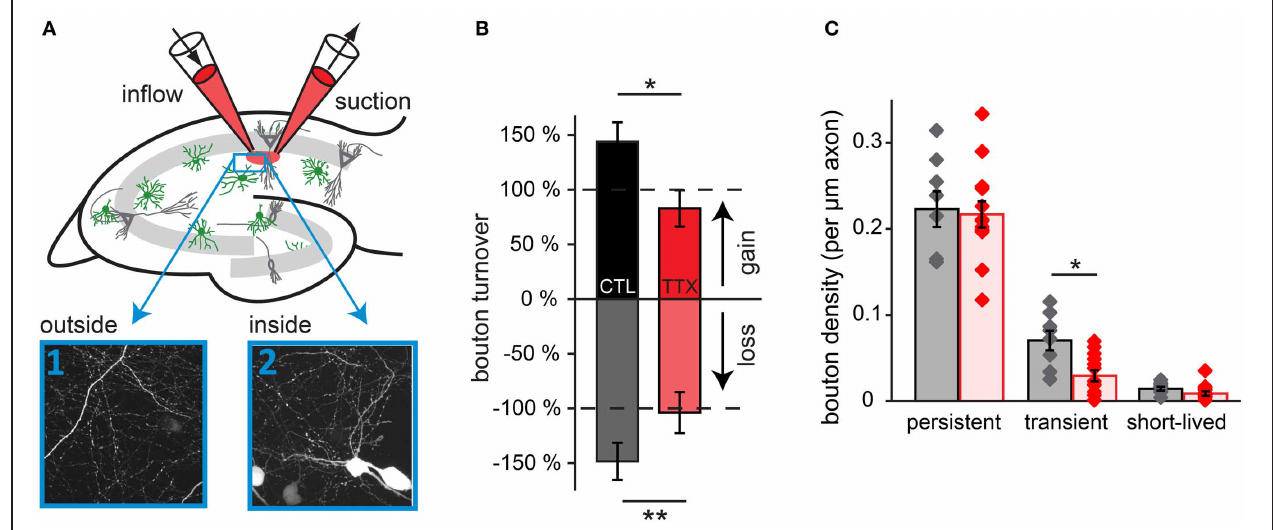
super fusion spot. (B) Normalized bouton turnover during perfusion with TTX and control solution. (C) Bouton density for each bouton category during perfusion with TTX and control solution. Control super fusion: 8 axons inside, 8 outside; TTX super fusion: 13 axons inside, 12 outside. Significance levels: ∗ p < 0 . 05, ∗∗ p < 0 . 01 (ANOVA, post-hoc Tukey